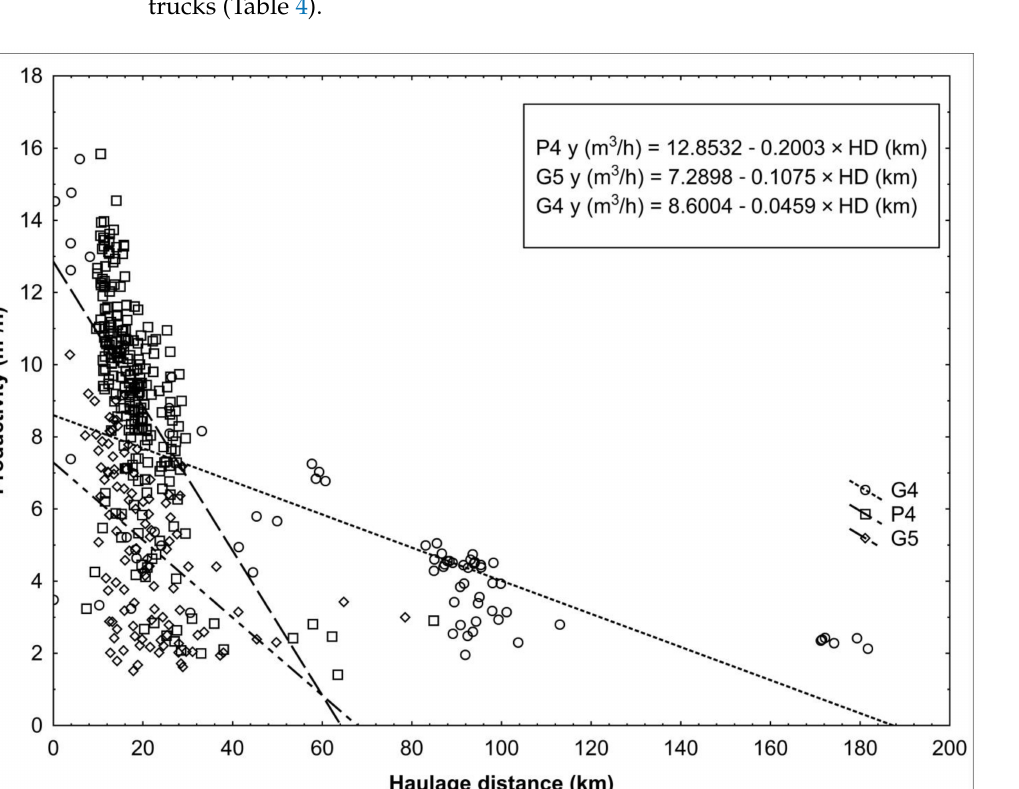
Figure 2. Productivity of the Scania P450 (P4), G500 (G5), and G440 (G4) logging trucks based on the haulage